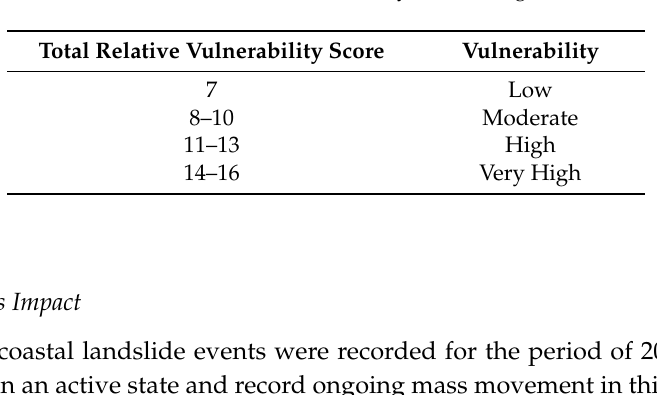
Table 4. Relative vulnerability level ratings.